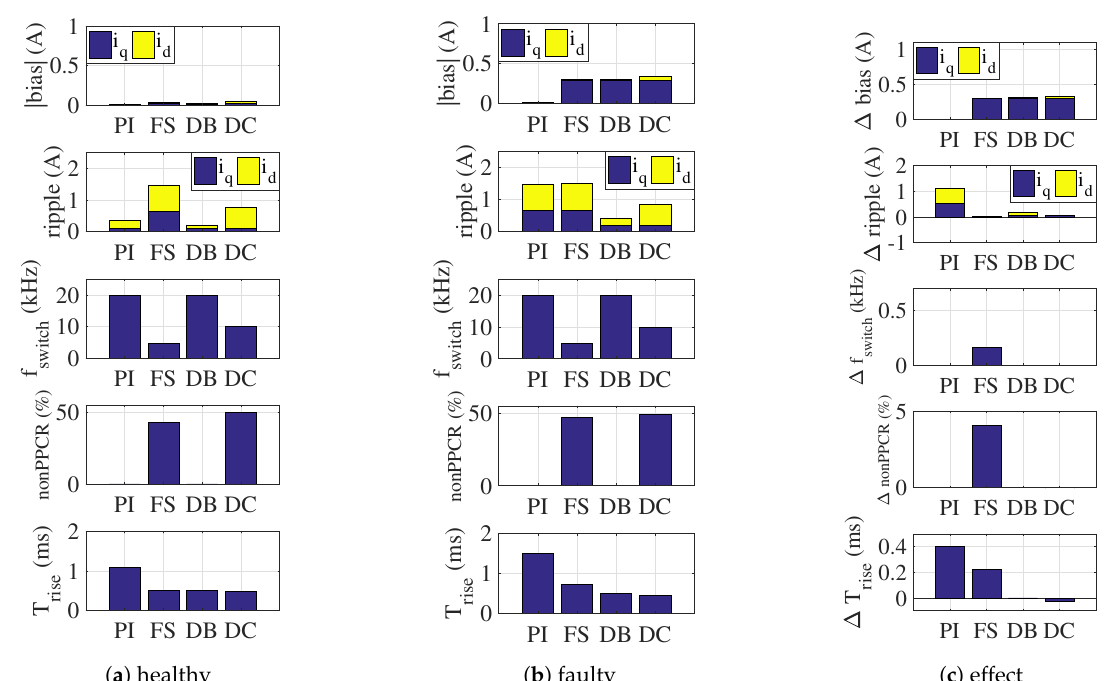
Figure 9. Simulated key performance indicators (KPIs) for V dc = 200 V and N = 800 rpm (PI = PI control; FS = FS-MBPC; DB = DB control; DC = MBPC with duty cycle calculation).